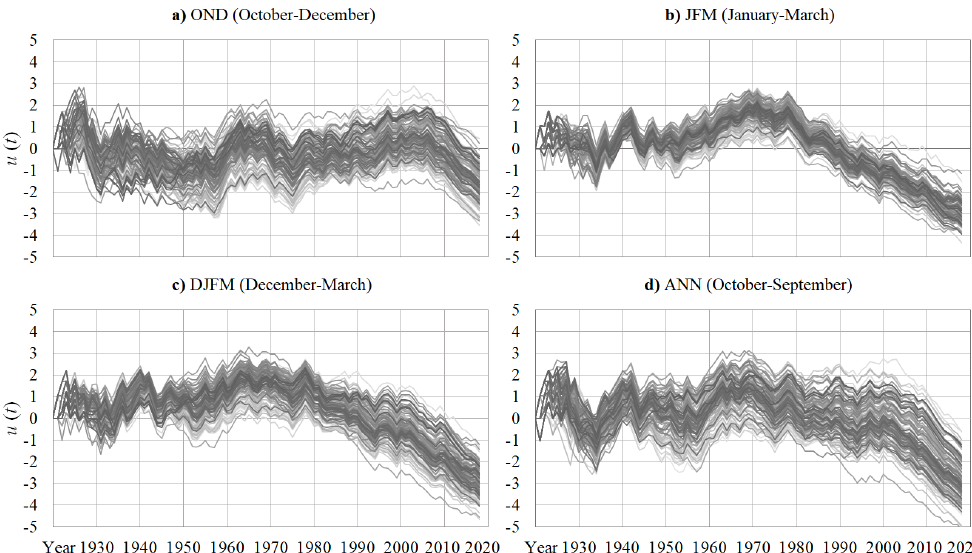
Figure 3. Progressive-trend series u ( t ) in grey scales, unitless, of the quarterly OND, JFM; four- monthly DJFM, and annual ANN grid-point rainfall series for Portugal (based on the 126 centroids of Figure 1b).